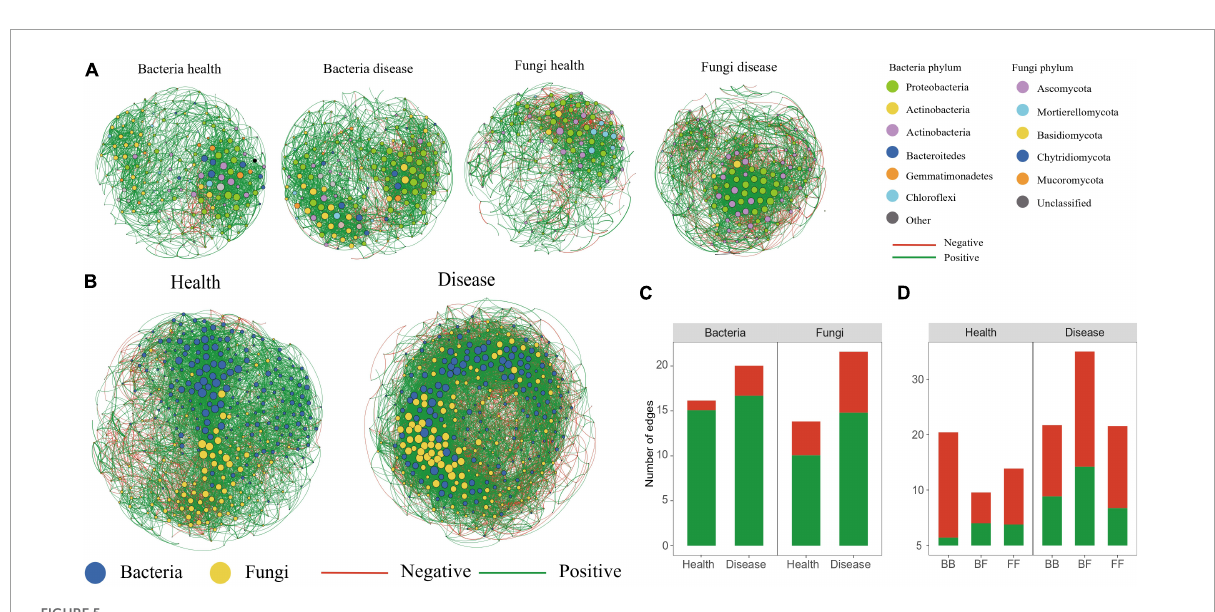
FIGURE5 Co-occurrence networks. Intra-kingdom co-occurrence networks (A) . The nodes are colored according to bacterial phylum and fungal phylum. Node size indicates the degree of connection. Edge color represents positive (green) and negative (red) correlations. Number of positive and negative edges of bacterial and fungal groups in health and disease networks (C) . Interkingdom co-occurrence networks (B) contained both bacterial and fungal taxa. Number of bacterial–bacterial (BB), bacterial–fungal (BF), and fungal–fungal (FF) correlations in the healthy and diseased networks. Green and red colors of the edges and column indicate positive and negative correlations, respectively (D)